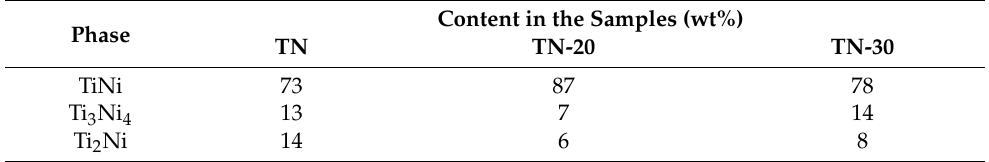
Table 1. Phase composition of the samples as evaluated by